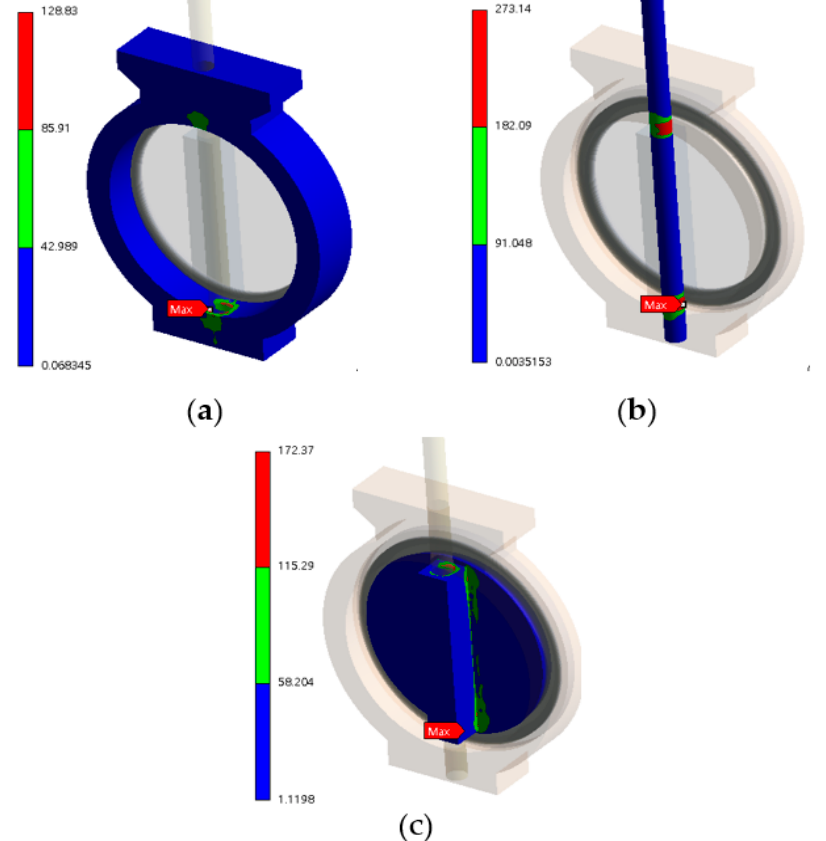
Figure 23. The maximum equivalent stress at each part: ( a ) body; ( b ) shaft; ( c ) disc.